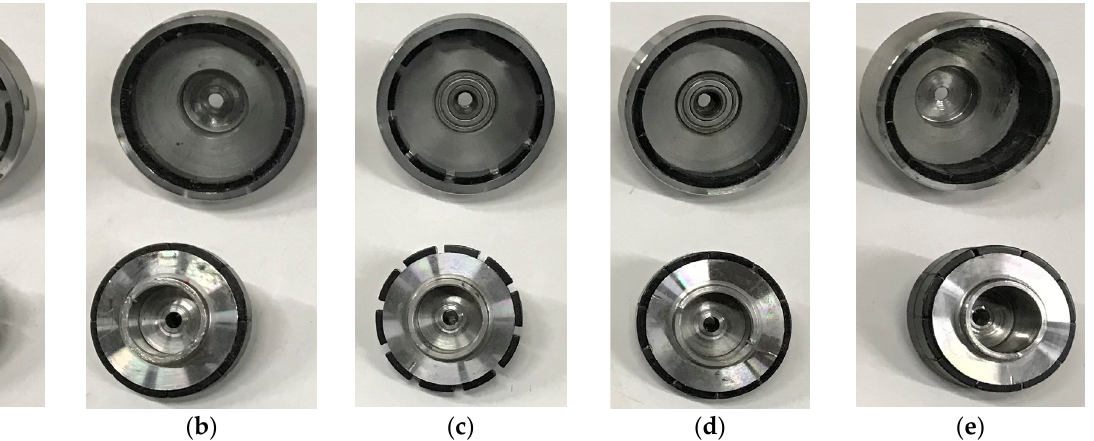
Figure 21. Various MC productions of: ( a ) 8-pole/0.8-embrace/3 mm-PM thickness/10 mm length; ( b ) 8-pole/0.98-embrace/4 mm-PM thickness/10 mm length; ( c ) 10-pole/0.8-embrace/4 mm-PM thickness/10 mm length; ( d ) 10-pole/0.98-embrace/4 mm-PM thickness/10 mm length; ( e ) 10-pole/0.98-embrace/4 mm-PM thickness/20 mm length.